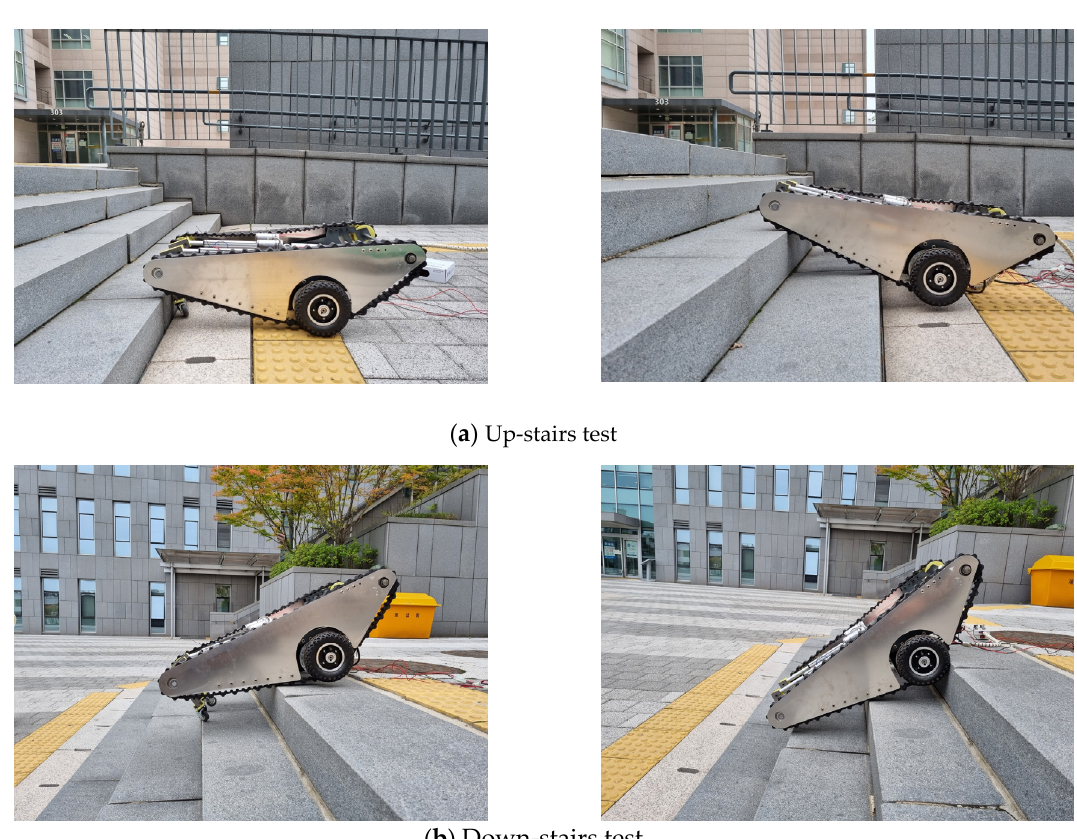
Figure 11. Stair test. ( a ) Up-stairs test. ( b ) Down-stairs